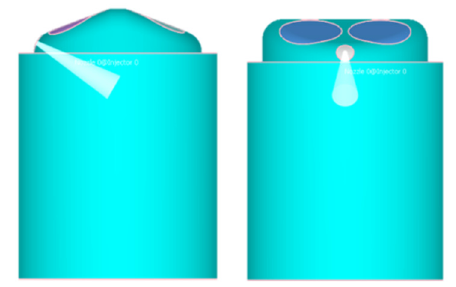
Figure 1. Geometry of cylinder used in computational fluid dynamic (CFD) simulation. Reproduced with permission from Aghahasani, M., etc., Energy Convers Manag.; published by Elsevier, 2022 [38]. Table 2. Engine specifications and operational conditions. Reproduced with permission from Aghahasani, M., etc., Energy Convers Manag.; published by Elsevier, 2022 [38]. Parameters